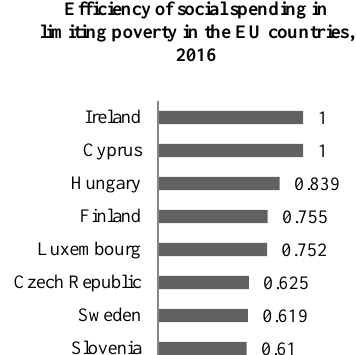
Figure 1. Efficiency of social spending in limiting poverty and income inequality in the EU